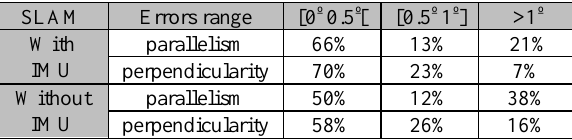
Table 3. Percentages of angles’ errors for parallelism and perpendicularity in two cases, SLAM with and without IMU.